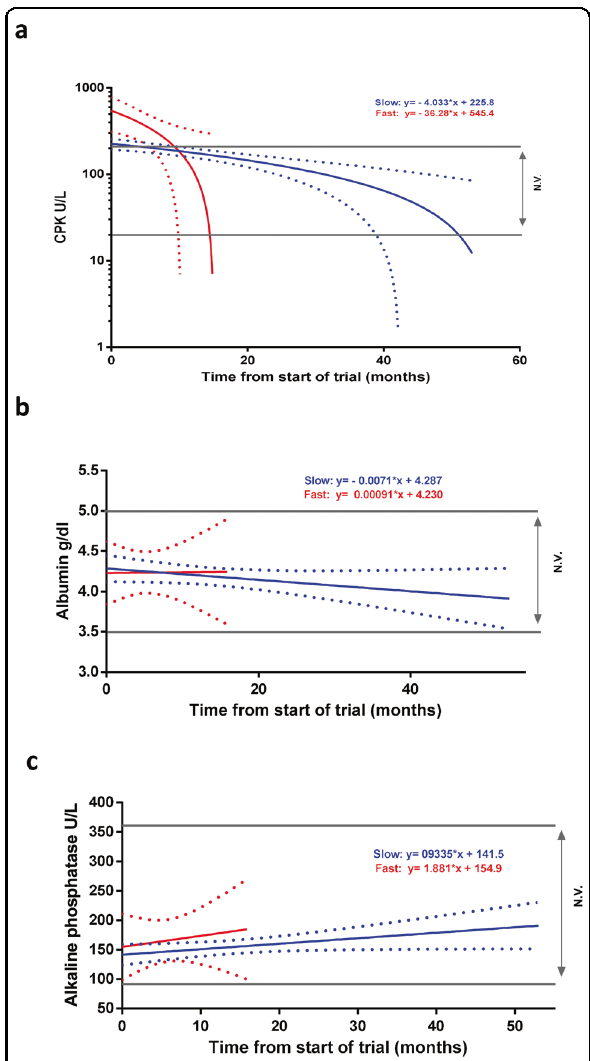
Fig. 5 CPK levels in slow and fast progressing patients. Linear regression analysis of a CPK, b albumin and c alkaline phosphatase in fast and slow progressing patients. CPK levels decrease in both group with higher rate decline in the fast progressing patients compared to the slow one. Albumin and Alkaline levels do not change in both groups a N = 11 (slow), N = 5 (fast); b N = 10 (slow), N = 4 (fast); c N = 9 (slow), N = 3